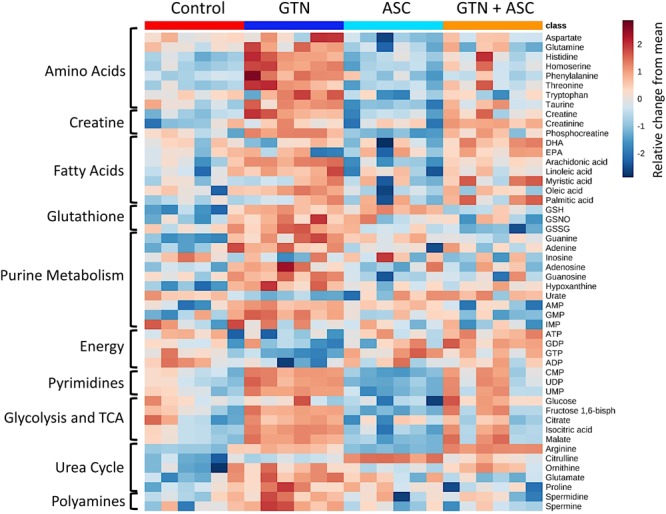
Heat map of metabolite abundance per treatment group. Metabolomics analysis was performed on control, ascorbic acid (ASC), glyceryl trinitrate (GTN), and GTN + ASC groups (n = 6/group). The metabolites were chosen based on top p-values and physiological significance. Colors indicate z-score (standard deviation from the mean). The heat map was generated with MetaboAnalyst 3.0 using normalized data (log transformation, Pareto scaling) using Euclidean distance measure.